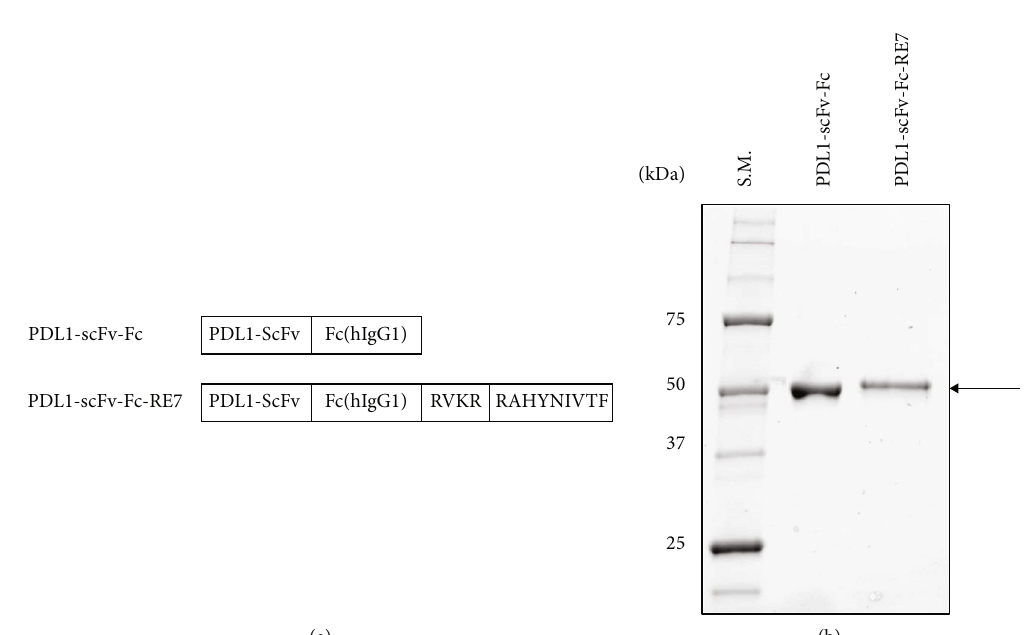
Figure 1: Generation and characterization of therapeutic chimeric proteins. (a) Schematic diagram of chimeric protein containing PDL1- scFv, Fc portion of human IgG1, furin cleavage site (RVKR), and E7 peptide (RAHYNIVTF). (b) SDS-PAGE of puri fi ed chimeric protein from Expi293F cells transfected with PD-L1-scFv-Fc and PD-L1-scFv-Fc-RE7 constructs. Arrow pointing at the bars indicating the size of PDL1-scFv-Fc and PDL1-scFv-Fc-RE7.